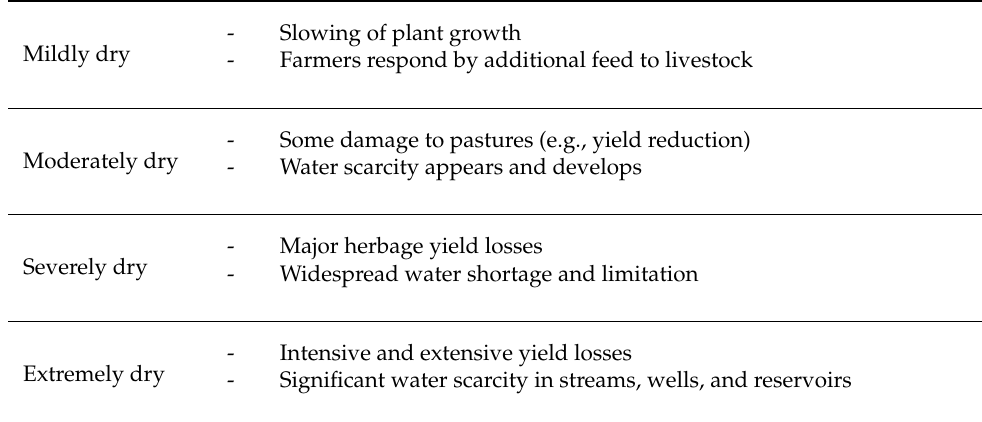
Table 3. Possible effects of dryness intensity (extracted and adapted from the National Drought Mitigation Center (NDMC) [68]).